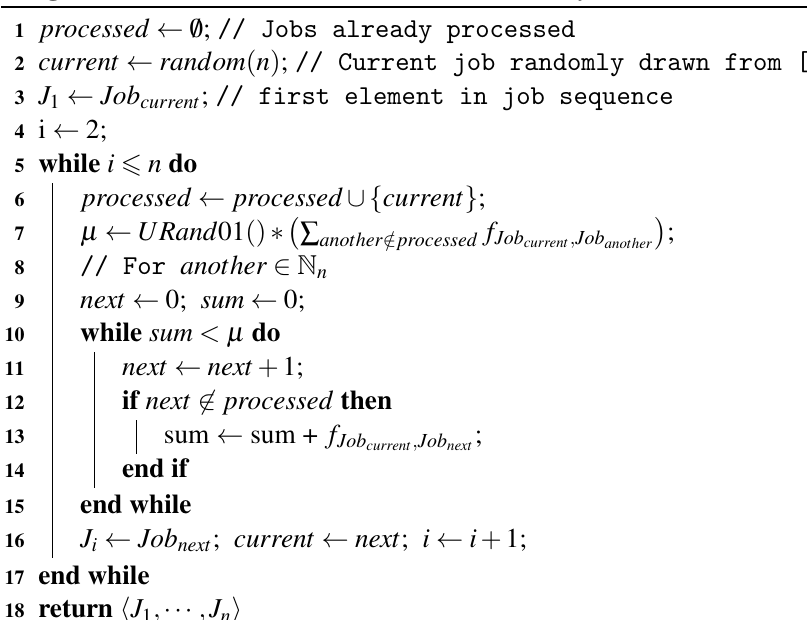
Algorithm 4: Method G ENERATE J OB S EQUENCE ( f )